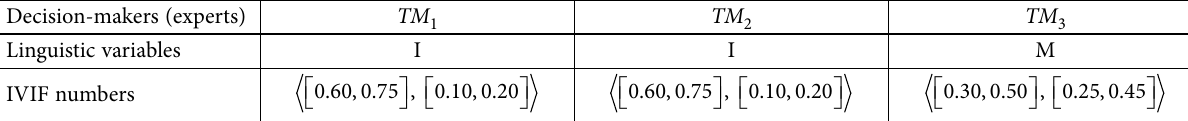
Table 3. Weights of team members